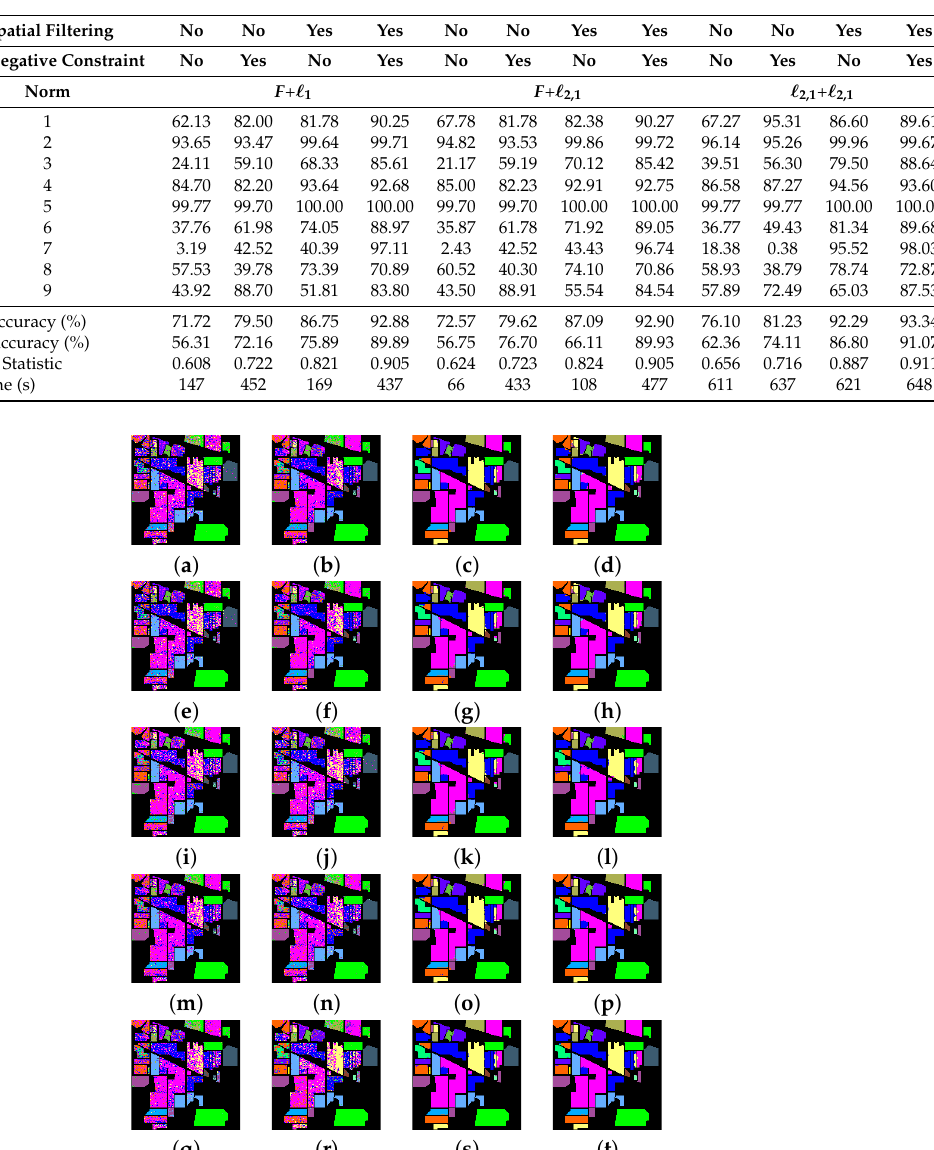
Table 6. Overall Accuracy, Average Accuracy, Kappa Statistic and Time of the Pavia University data set when dealing with all the test pixels simultaneously.